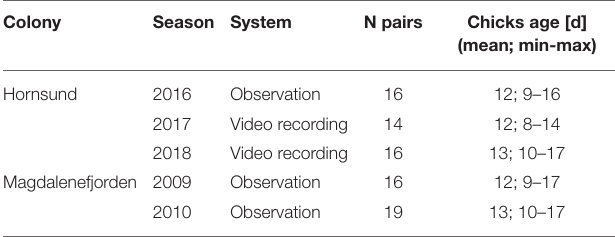
TABLE 1 | Detailed sample sizes across the five seasons.